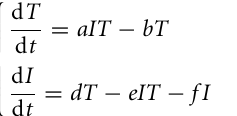
FIGURE 2 | Model of dynamic interplay between conventional T cells and regulatory T cells . Nonself-specific as well as some self-specific thymocytes that survived negative selection and were not selected asTregs enter the periphery as naïve T cells. A part of detected autoreactive thymocytes differentiate intoTregs in the thymus and reside in the periphery in resting state. Upon Ag-stimulation by APCs, naïve T cells and restingTregs become